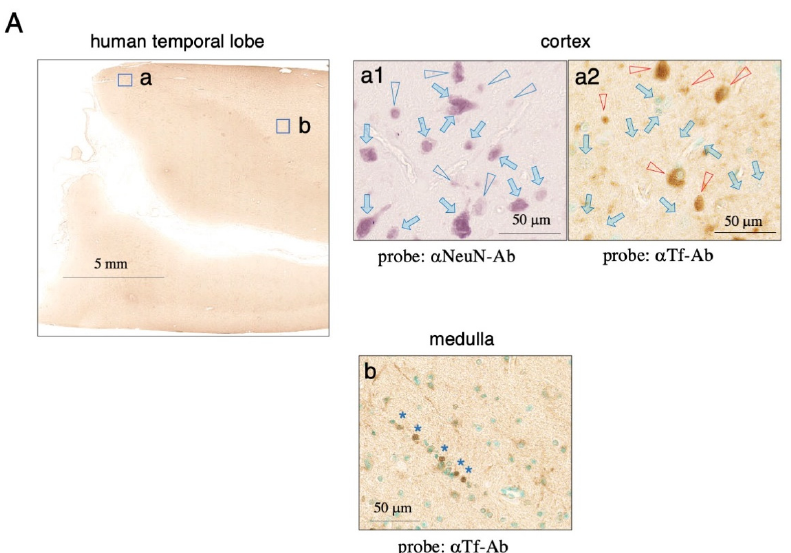
Figure 7. Immunohistochemistry using anti ‐ Tf antibody for human temporal lobe . Sections of human temporal lobe were stained with anti ‐ human Tf antibody and methyl green ( A ). Pairs of mirror ‐ image sections from the cortex were prepared, with one section stained with anti ‐ NeuN antibody for detecting neurons ( a1 ), and the other with anti ‐ human Tf antibody and methyl green for nuclear staining ( a2 ). NeuN ‐ positive cells are indicated with blue arrowheads ( a1 ), while the same positions on the mirror ‐ image section stained with anti ‐ Tf antibody are indicated with red arrowheads ( a2 ). NeuN ‐ positive but Tf ‐ negative neurons are indicated with blue arrows ( a1 , a2 ). In a high magnifica ‐ tion image of the medulla, Tf ‐ positive cells forming a row are indicated with blue asterisks ( b ). 2.5. Expression of Tf mRNA and Tf Protein in Human Hippocampal Tissue Tf mRNA and protein expression were examined in pairs of mirror ‐ image sections of human hippocampus subjected to in situ hybridization (Figure 8(A1)). Anti ‐ human Tf antibody staining revealed faint signals in the hippocampal region (Figure 8(A2)), while diffuse signals surrounding blood vessels were also observed. In a high magnification im ‐ age, positive antisense signals were detected in CA2 neurons, which were only sparingly stained with anti ‐ human Tf antibody (Figure 8(B1,B2)). These results suggest that human hippocampal neurons showed discordant expression of Tf mRNA and Tf protein.